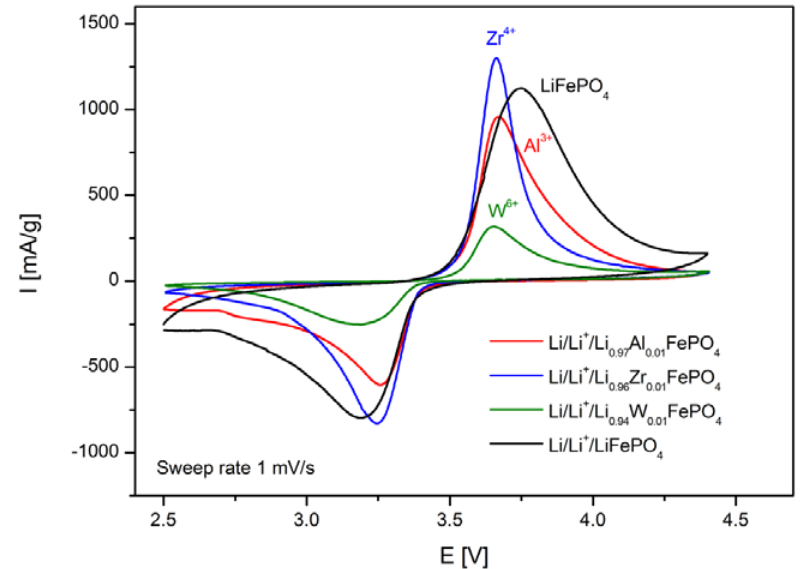
Figure 15. Cyclic voltammograms recorded for lithium cells with Li Zr FePO , Li W FePO and LiFePO Li 0.96 0.01 4 0.94 0.01 4